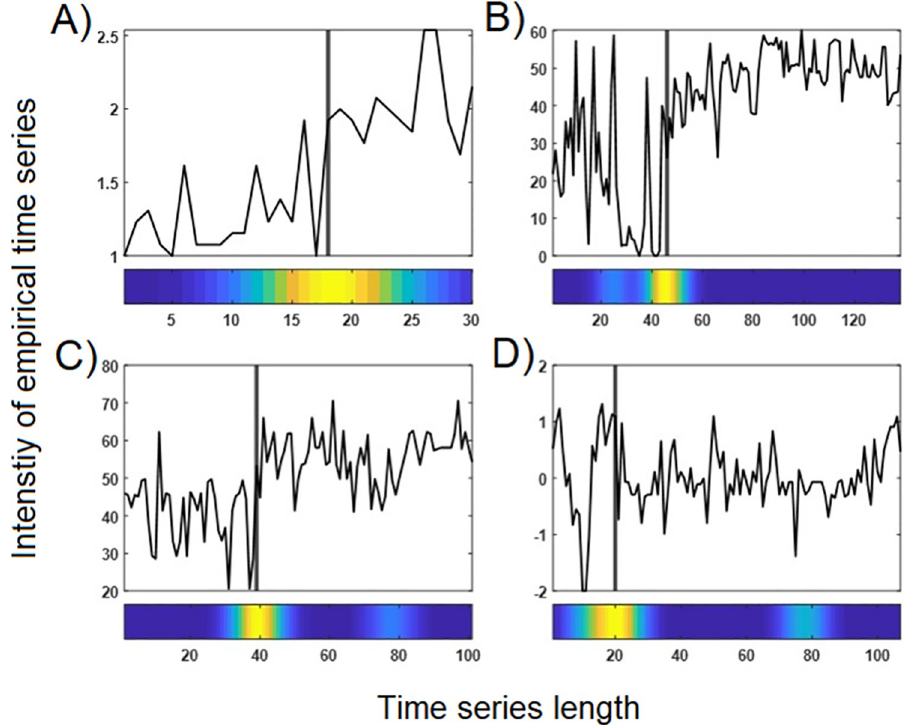
Fig 6. PTDA applied to four different psychological time series. A) Time Series of the depression subscore of the SCL-90 from a open access dataset (see Methods). B) Time series of the “child-state” of a patient with dissociative identity disorder during the psychotherapy process (Schiepek et al., 2016). C and D) Time series of the psychotherapeutic process. The change point is marked by the vertical black line. The bar below gives an impression of the convergence of the CPs over all methods. X-axis: Measurement points (daily assessments): Y-axis: Intensities of the values (A, B, C); z-transformed values of the factor “motivation for change” (D).